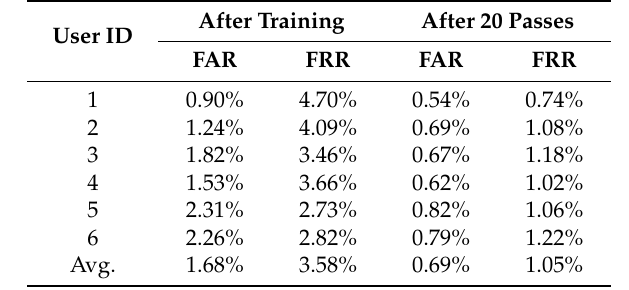
Table 1. False acceptance rate (FAR) and false rejection rate (FRR) score for different gestures after training and after 20